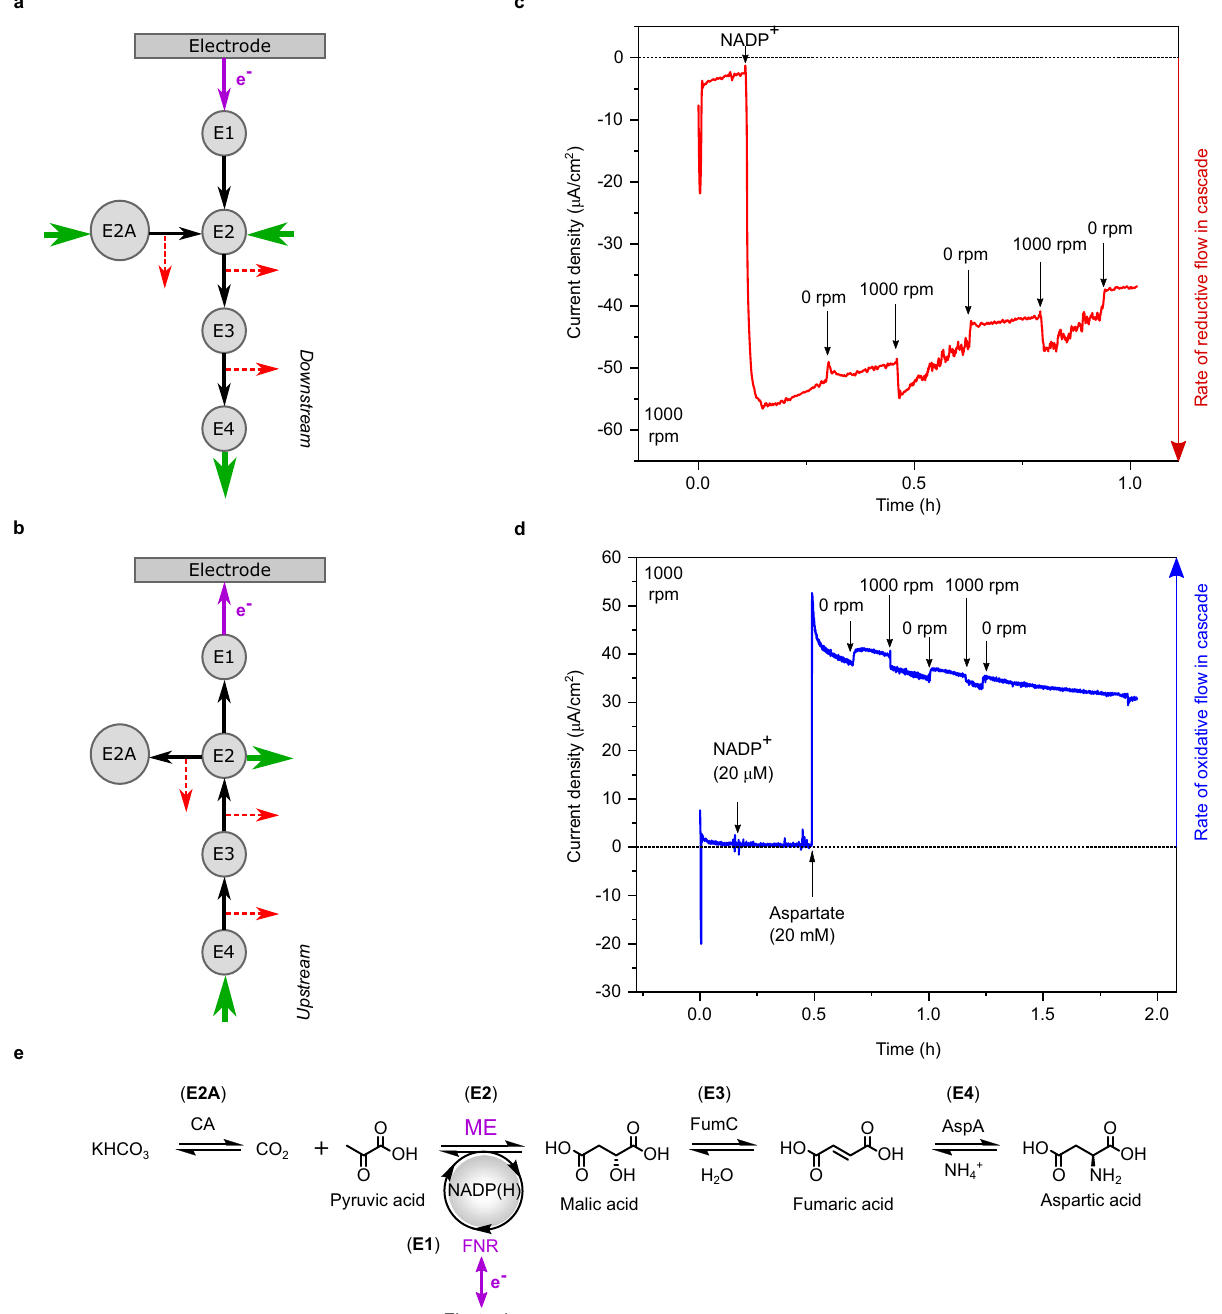
Fig. 3 Controlling and monitoring the rate and directionality of an enzyme cascade. a The nanocon fi ned cascade in downstream notation. Enzymes E1 and E2 are, respectively, FNR and a NAD(P)(H) dehydrogenase and they represent the transducer-engine pair at which the rate of reaction fl ow along the cascade is recorded directly as current. Here the rest of the cascade is downstream with respect to the cofactor-dependent step (E1 – E2 pair). Intermediates are passed to the next enzyme or escape (dotted red lines) into the bulk solution. b The nanocon fi ned cascade in upstream notation: the rest of the cascade is upstream of the cofactor-dependent step. c Rotation-rate dependence experiment for the system (CA/FNR/ME/FumC/AspA)@ITO/PGE (0.03 cm 2 ) in a buffer containing NH 4 Cl, KHCO 3 , and pyruvate at pH 7.5, 25 °C, rotation rate 1000 rpm, under N 2 atmosphere. Arrows signify injection of NADP + (to a fi nal concentration of 20 µ M) and switching rotation off (0 rpm) and on (1000 rpm). d Continuation of the experiment carried out in panel c: the cell was washed carefully, a fresh buffer was added and rotation (1000 rpm) was switched on. Arrows signify injection of NADP + (to 20 µ M) and aspartate (substrate of E4, to 20 mM) and successive switching off and on of rotation. e Cascade with E1, E2, etc, identi fi ed with the different enzymes making up the cascade unit: downstream direction runs left to